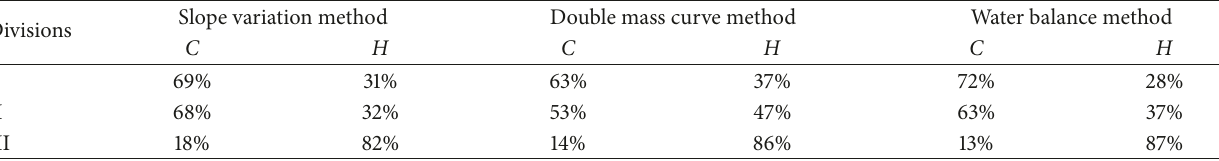
Table 3: Contributions of climate change and human activities by slope variation, double mass curve, and water balance method. Slope variation Divisions